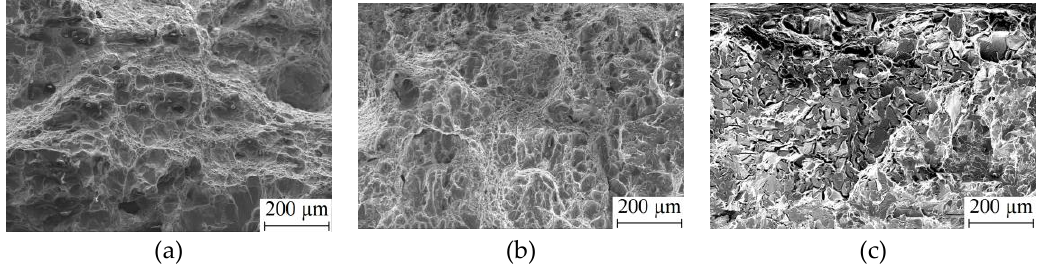
Figure 9. Scanning Electron Microscope (SEM) images of the fracture surface of impact bending specimens tested at different temperatures. ( a ) T = 20 °C; ( b ) T = −20 °C; ( c ) T = −60 °C.